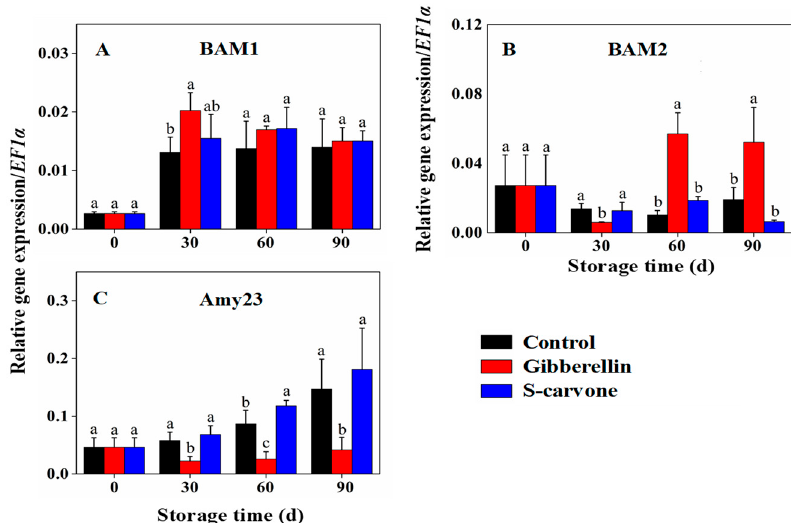
Figure 6. Effects of gibberellin and ( S )-carvone on gene expression/ EF1a in potato tubers during 4 °C low temperature storage. ( A ) Gibberellin and ( S )-carvone effect on expression of BAM1 . ( B ) Gibberellin and ( S )-carvone effect on expression of BAM2 . ( C ) Gibberellin and ( S )-carvone effect on expression of Amy23 . The error bars represent the standard errors. Means with the same letters are not statistically different according to the least significant difference test at p < 0.05.